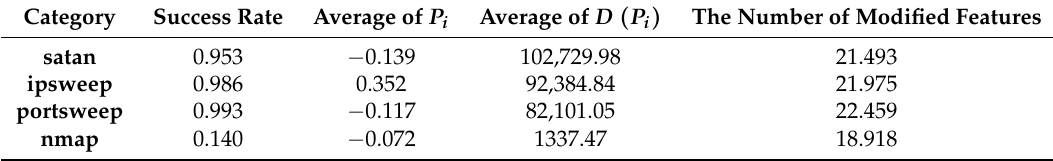
Table 5. The results of TLTD-I. The data in the table is the average of the 1000 sample test